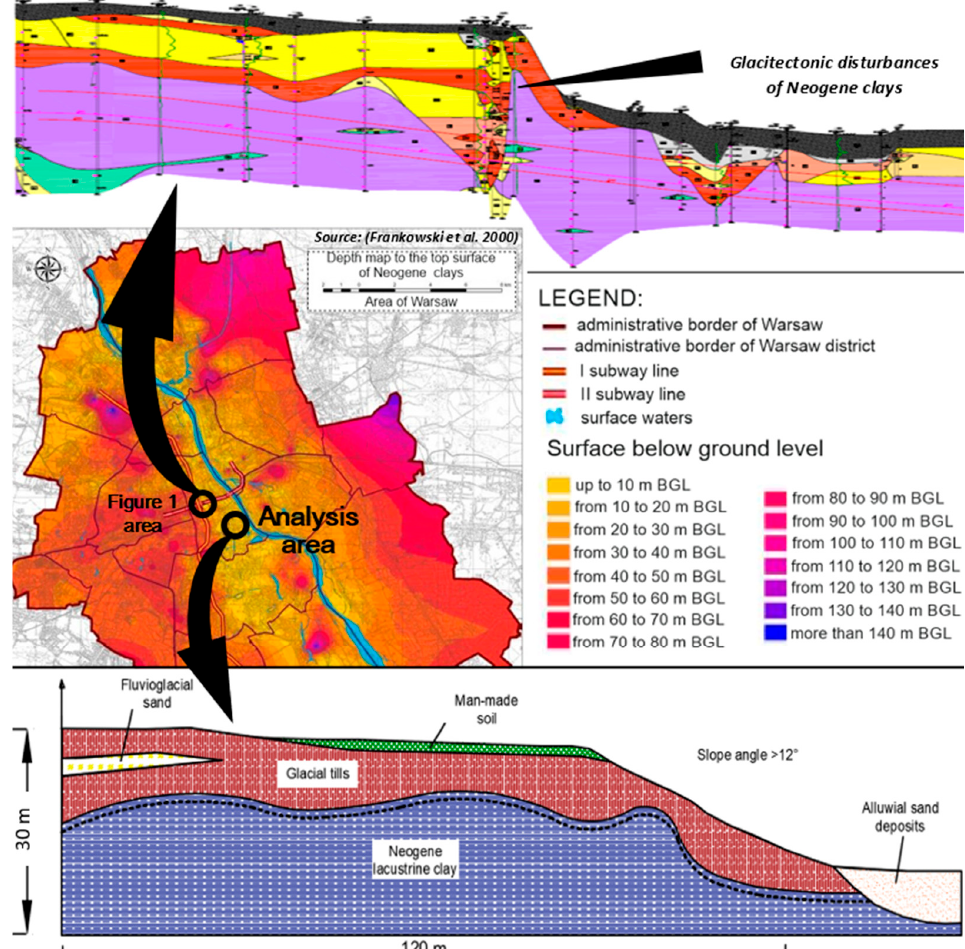
Figure 2. The roof of the Neogene clay within the borders of Warsaw with two exemplary sections crossing the Warsaw Slope (modified from [9,34]).